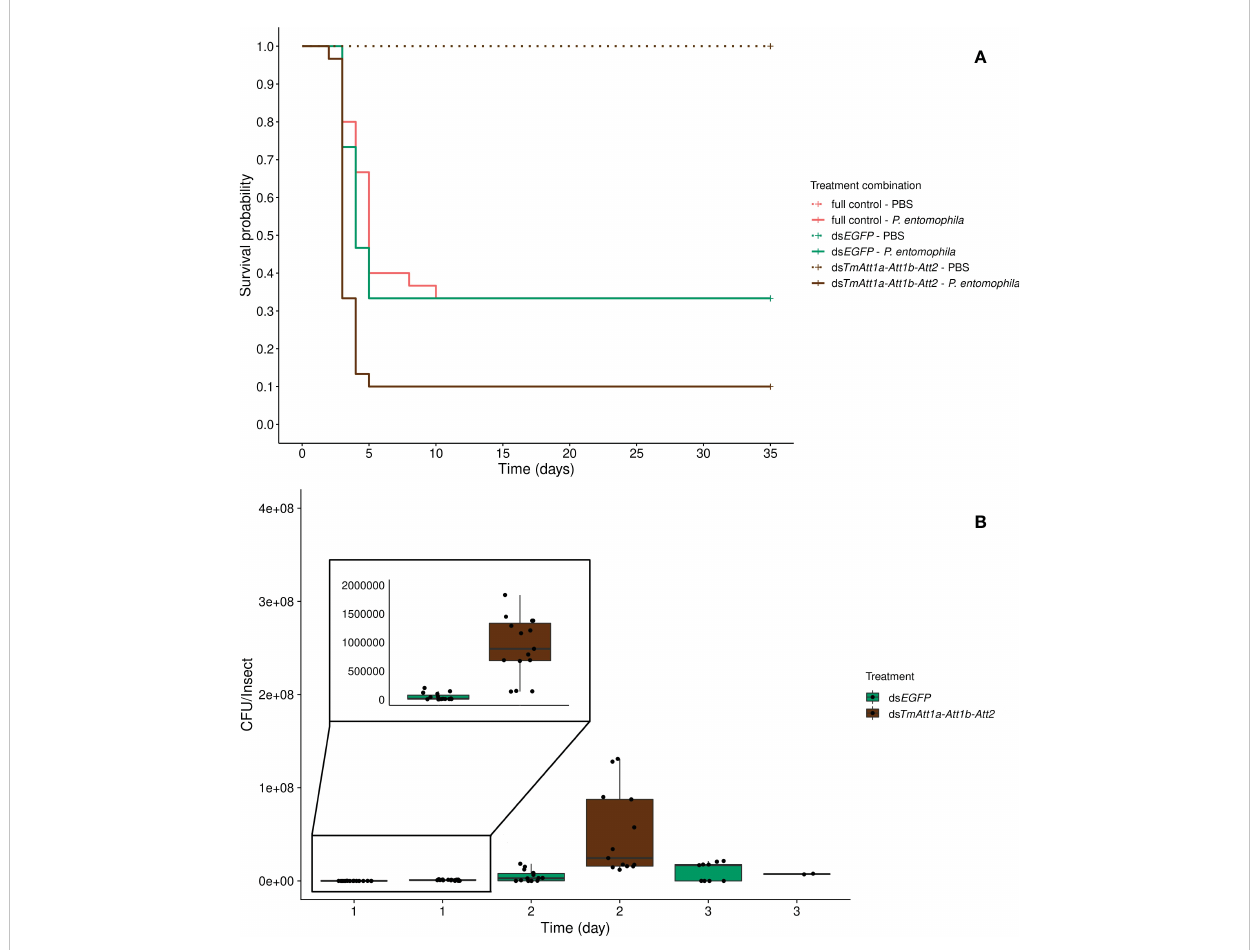
FIGURE 6 (A) Effect of TmAttacin1a-1b-2 ( TmAtt1a-Att1b-Att2 ) triple-knockdown on survival of Pseudomonas entomophila infected Tenebrio molitor females over 35 days. ds EGFP was injected as a negative control for the nonspeci fi c effects of dsRNA and the third group includes dsRNA untreated control. Two independent experiments each performed on 15 females per treatment group. Each dsRNA-treated or dsRNA-untreated groups were infected with P. entomophila on day 4 after dsRNA treatment based on the data on knockdown ef fi ciency (Figure S15). Pink dashed line: Full control-PBS; Turquoise dashed line: ds EGFP - PBS; Brown dashed line: ds TmAtt1a-Att1b-Att2 - PBS; Pink line: Full control - P . entomophila ; Turquoise line: ds EGFP - P . entomophila ; Brown line: ds TmAtt1a-Att1b-Att2 - P . entomophila . (B) Bacterial load in dsTmAtt1a-Att1b-Att2 -silenced T. molitor challenged with P. entomophila at 1-, 2-, and 3-day post-infection. The colony-forming units (CFU) recovered from tissues of T. molitor females from dsTmAtt1a-Att1b-Att2 (brown) and ds EGFP (control, turquoise). In the box plots, the lower ( fi rst) quartile is the closest boundary to zero, the line within the box marks the median (second quartile), and the upper (third) quartile. Each dot represents the CFU count in an individual beetle. The bars represent the 1.5 interquartile. Sample sizes are given in Table